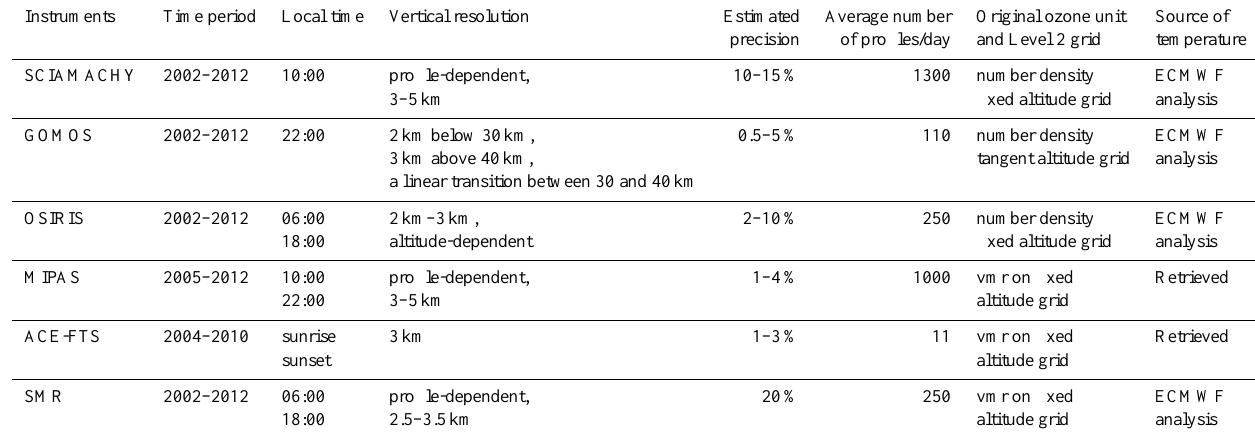
Table 1. Overview of data sets used (adopted from Sofieva et al., 2013). If necessary, the profiles were converted to volume mixing ratio (vmr) and interpolated to a 1km vertical